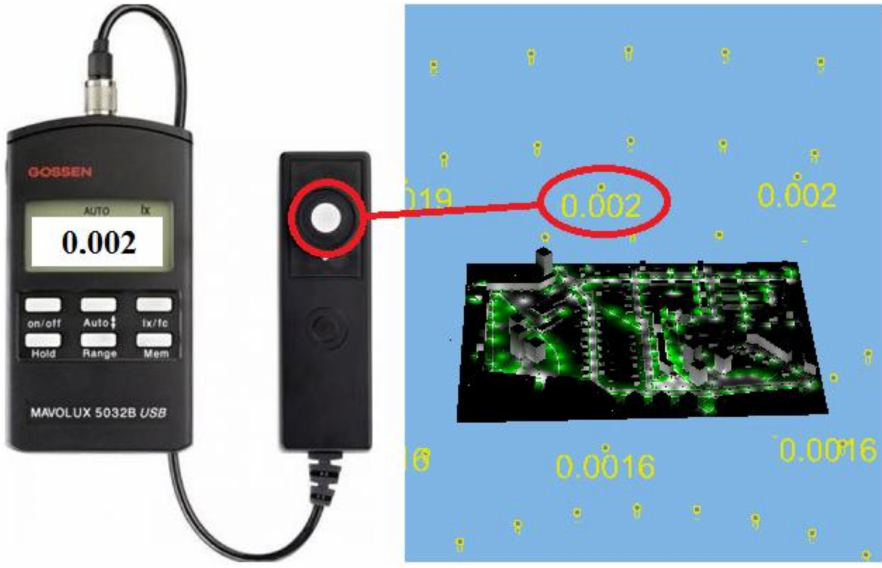
Figure 3. Calculation grid showing normal illuminance of the software goniophotometer [11].